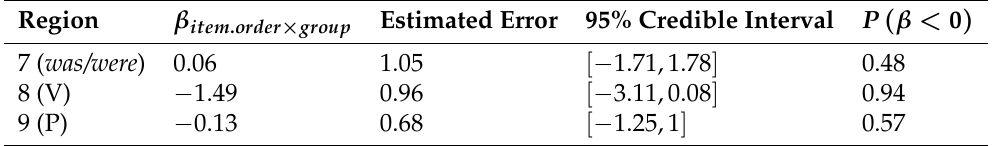
Table 1. Coefficients for the effect on TARTs from the interaction between Control/Bonus reward group and the item order, per region, according to Bayesian Mixed-effect models.